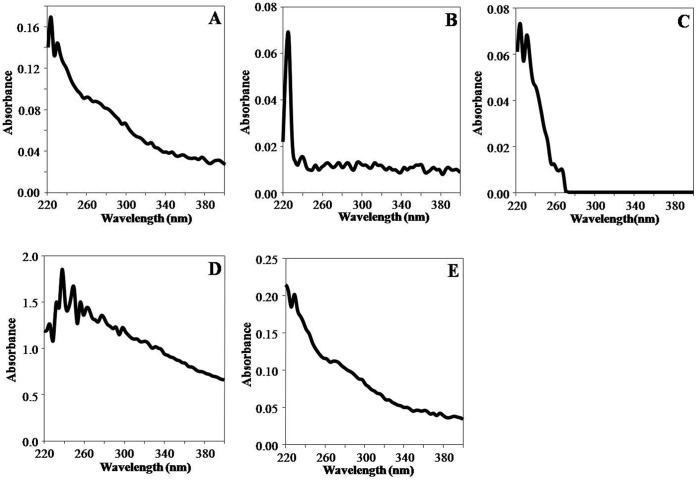
UV-visible spectra of PLA NPs synthesized using PEs as stabilizer/emulsifier.(A) PLA-1 (B) PLA-2 (C) PLA-3 (D) PLA-4 (E) PLA-5. UV-Vis spectra were recorded on nanodrop spectrophotometer by loading 2 µl of each PEs synthesized PLA NPs.